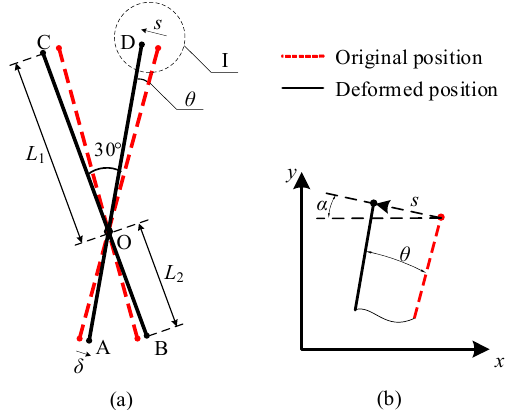
Figure 4. ( a ) Deformation schematic of the X-shaped flexible hinge mechanism, and ( b ) local enlarged view of the part I in Figure 4a.